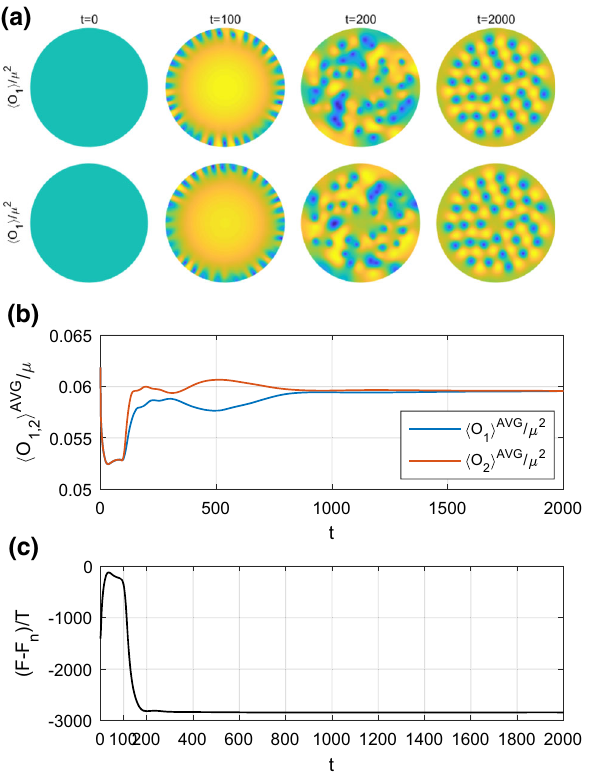
Fig. 2 a The dynamical formation of two-component vortex lattice at separate times with R = 20 , Ω = 0 . 1 and η = − 0 . 2. The temperature is T = 0 . 82 T 0 c . The top row is component (cid:3) O 1 (cid:4) and the second row is component (cid:3) O 2 (cid:4) . b The time evolution of average value of order parameter. c The time evolution of rescaled free energy under the same parameters as above